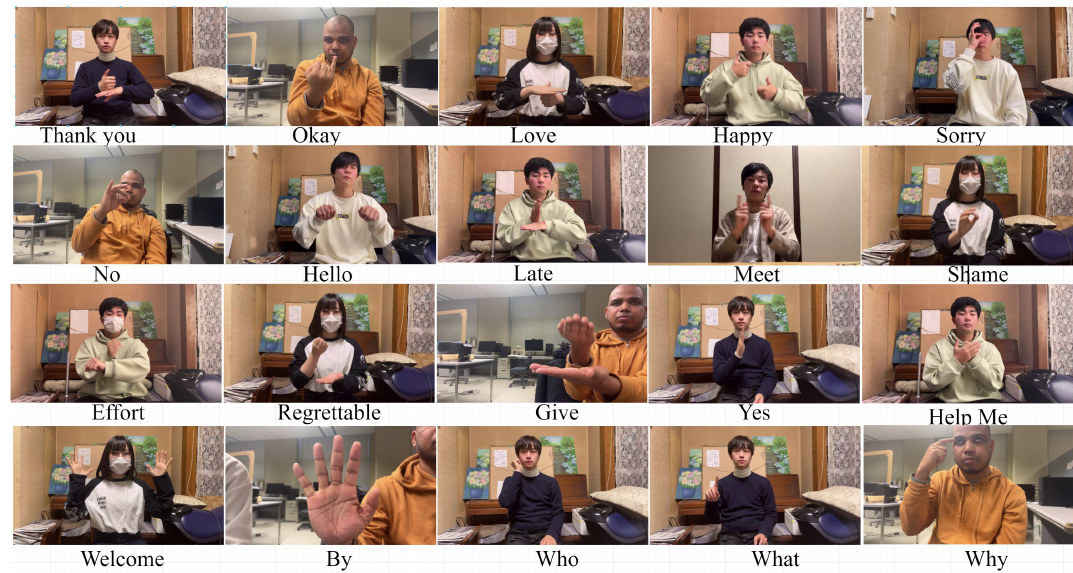
Figure 2. Proposed Korean sign language